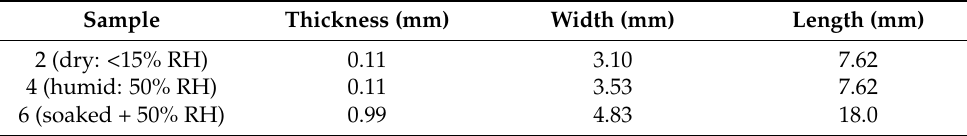
Table 1. PVA Sample Measurements and Test Conditions.